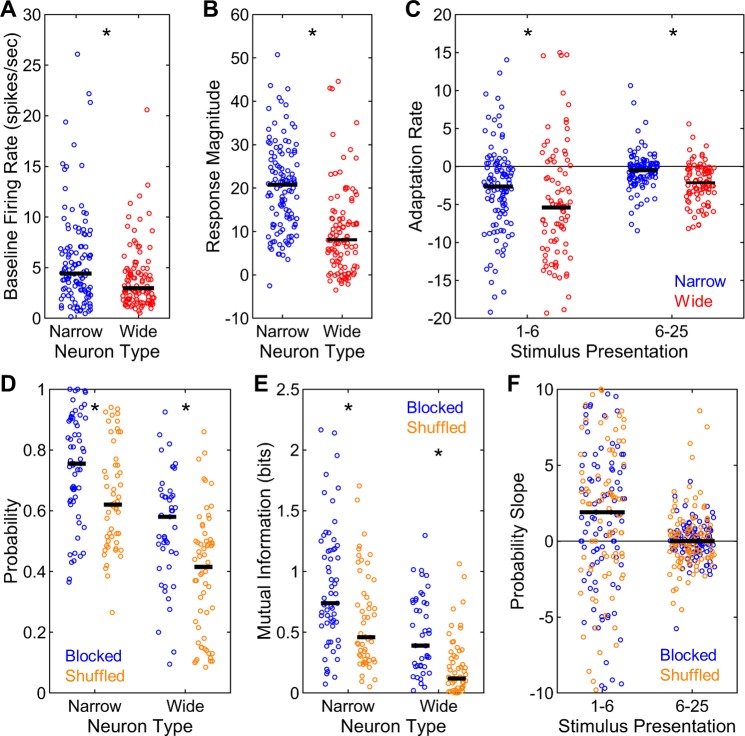
Single-unit response properties and neural decoding in blocked and shuffled sequences.(A) Firing rates during silent baseline conditions were higher for narrow than for wide spike neurons. (B) Stimulus-driven response magnitudes also showed the same effect. (C) Adaptation rates were more negative for wide then for narrow spike neurons both for presentations 1–6 and 6–25. (D) Correct neural decoding probabilities were higher in the blocked than in the shuffled sequence for both narrow and wide spike neurons. In addition, narrow spike neurons had higher correct neural decoding probabilities than did wide spike neurons in both the blocked and the shuffled sequence. (E) Mutual information also showed the same effects. (F) The slopes of correct neural decoding probabilities were higher than zero for presentations 1–6 than for presentations 6–25. Horizontal black bars indicate medians. Asterisks denote significant differences.